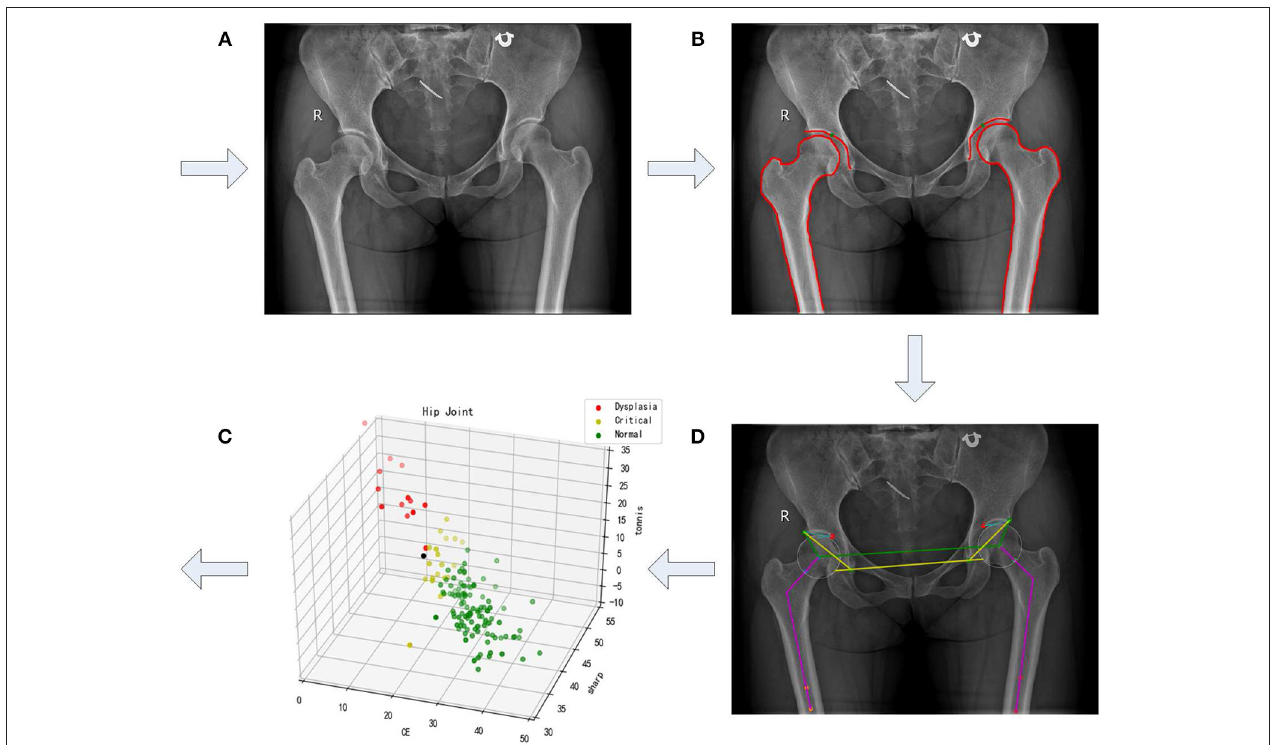
FIGURE 1 | A framework of semi-automatic method for diagnosis of hip dysplasia on X-ray films. (A–D) correspond to four steps of the framework. (A) refers to an original X-ray file of hip joint. (B) represents the manually marked results. (C) corresponds to the automatic angle measurement. (D) shows the corresponding scatter in the three-dimensional space with its three directions representing CE, sharp, and Tonnis